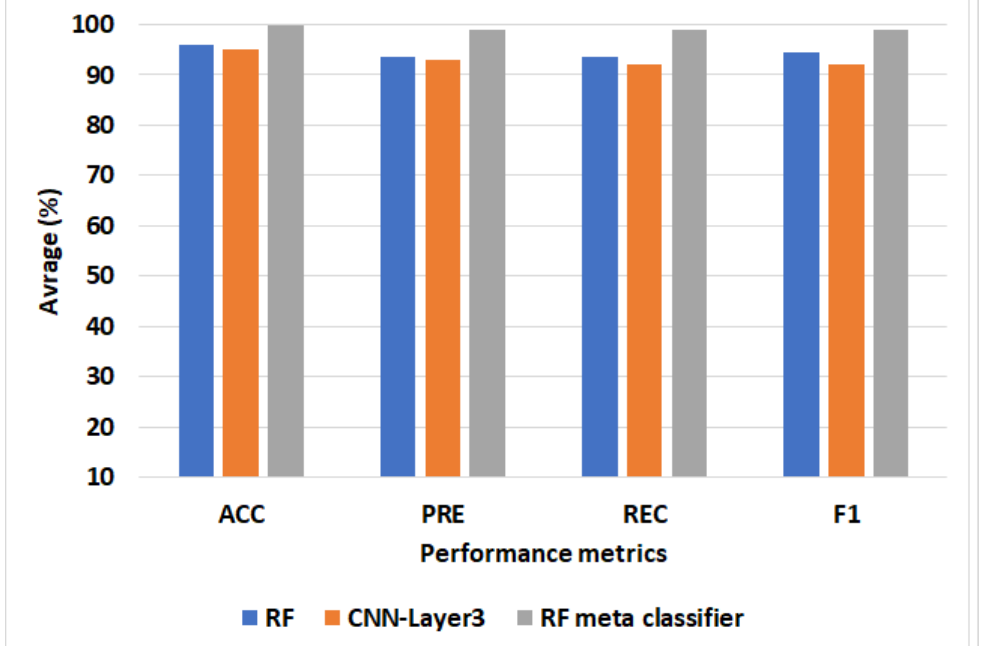
Figure 5. The average of ACC, PRC, REC, and F1 when applying the models to the PTM